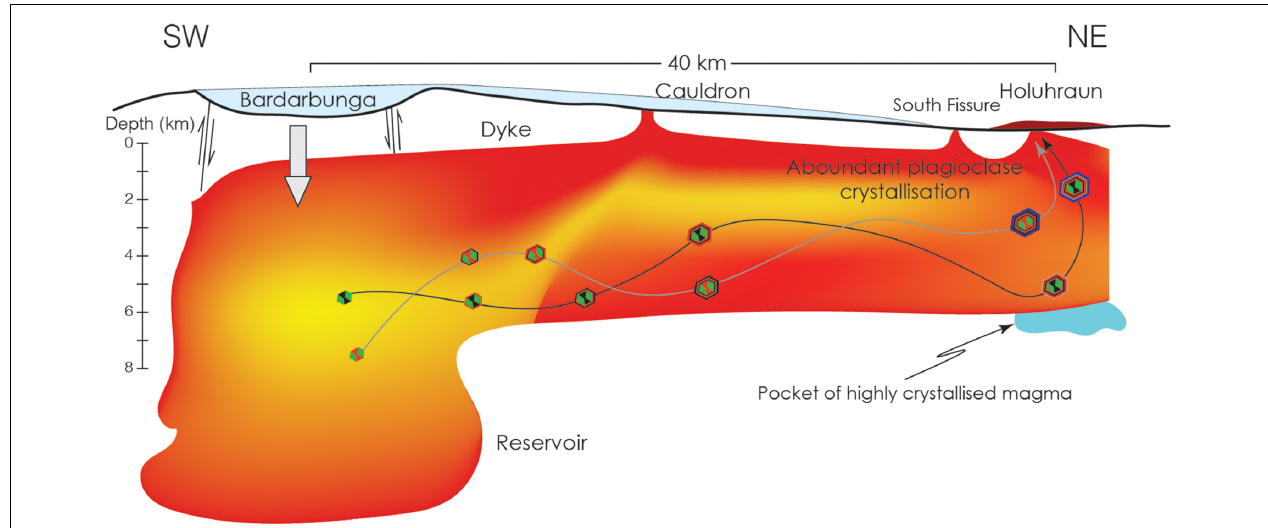
FIGURE 12 | Cartoon (not to scale) showing the potential path followed by two crystals during the 2014–2015 Bárdarbunga–Holuhraun eruption, which would best account for our measurements and calculations. The depths are approximative and based on earthquake locations and reconstruction by Woods et al. (2019). The figure is partly inspired by Gudmundsson et al. (2016), Hartley et al. (2018), Hudson et al. (2017), and Woods et al. (2019).